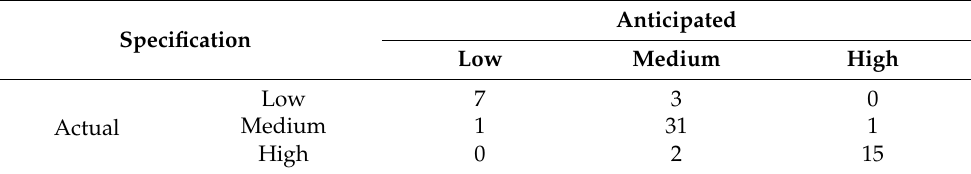
Table 8. The contingency table for the composite